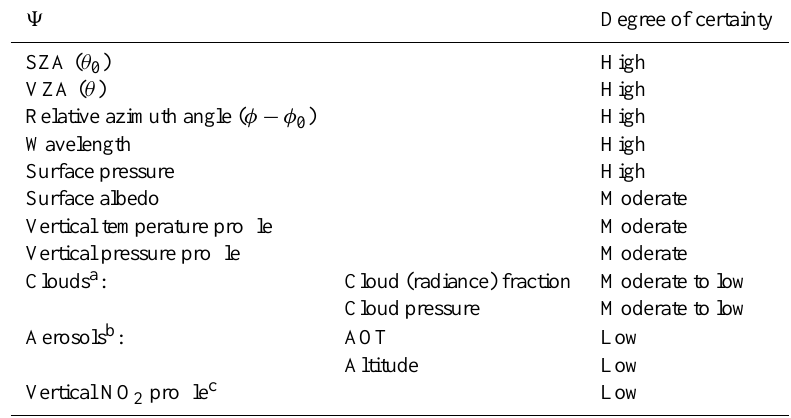
Table 1. List of the physical variables ( (cid:57) ) required for the computation of the tropospheric NO 2 AMF, through the altitude-resolved AMF a(p ∗ ) . For each of these variables, an indication about its degree of certainty is given. (cid:57) Degree of certainty SZA ( θ 0 ) High VZA ( θ ) High Relative azimuth angle ( φ − φ 0 ) High Wavelength High Surface pressure High Surface albedo Moderate Vertical temperature profile Moderate Vertical pressure profile Moderate Clouds a : Cloud (radiance) fraction Moderate to low Cloud pressure Moderate to low Aerosols b : AOT Low Altitude Low Vertical NO 2 profile c Low a Boersma et al. (2007) evaluated that an uncertainty of 0.05 on the cloud fraction and 60 hPa on the cloud pressure respectively contribute up to 30 and 15% to the (relative) tropospheric NO 2 AMF. While inter-comparison studies show relative good agreements for the OMI cloud fractions (Stammes et al., 2008; Sneep et al., 2008) over cloudy scenes, the retrievals can be affected by aerosols. Thus, the degree of